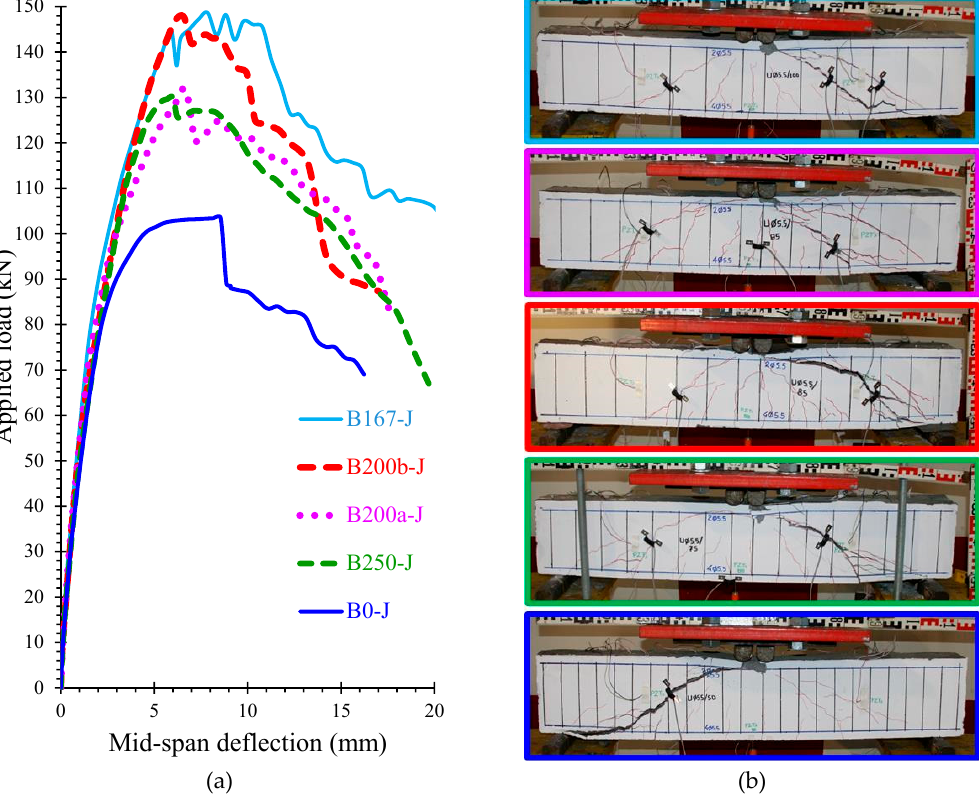
Figure 8. ( a ) Experimental behavior of the jacketed beams in terms of applied load versus mid-span deflection; ( b ) cracking patterns at failure.